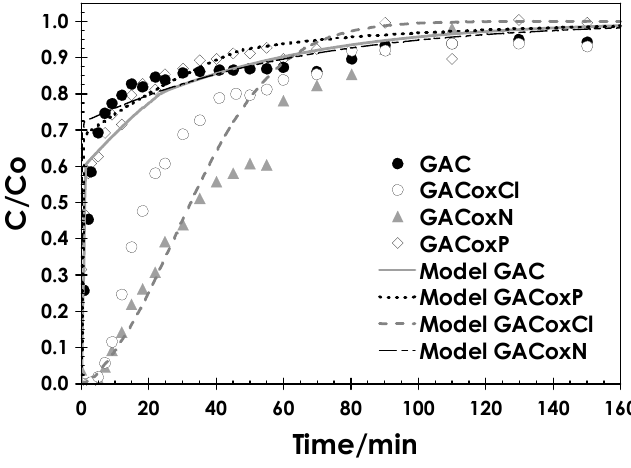
Figure 5. Cd dynamic adsorption tests onto GAC, GACoxCl, GACoxN, and GACoxP adsorbents (dp = 500 μ m). T = 25 °C, C 0 = 50 mg ∙ L − 1 ; Q = 1.8 L ∙ h − 1 .